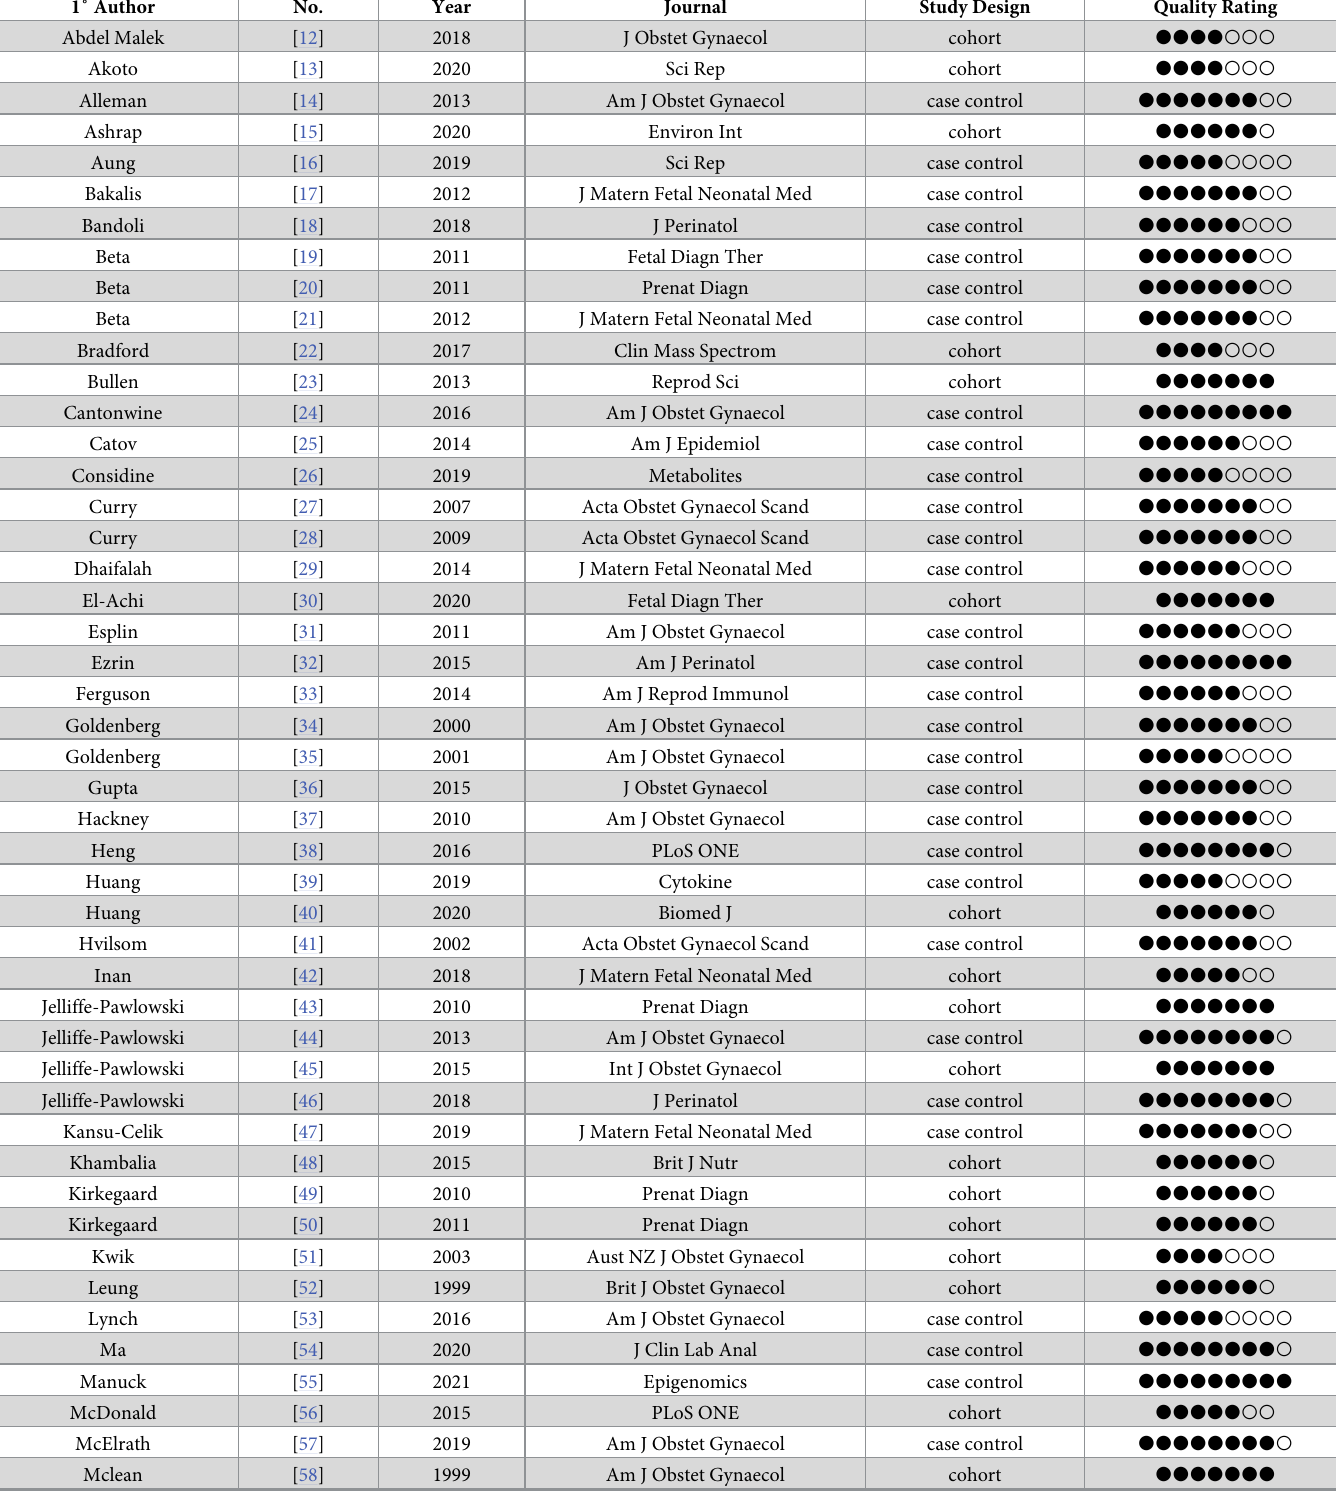
Table 1. Summary and quality assessment of studies included in